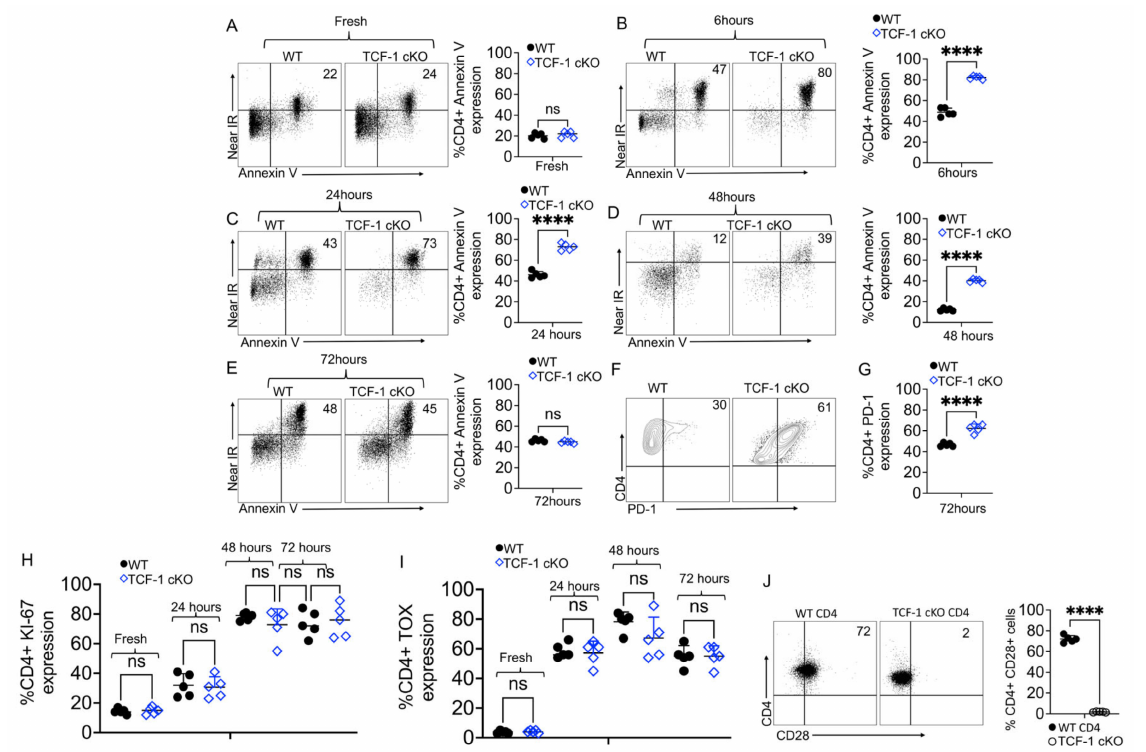
Figure 5. TCF-1 regulates CD4 T cell survival and persistence. ( A – E ) Splenocytes from either WT or TCF-1 cKO mice were isolated and either activated with anti-CD3/CD28 antibodies for 6, 24, 48, or 72 h in culture or left unstimulated, and cells were stained for Annexin V and Near IR to determine the dead, apoptotic and live cells. ( A ) Flow plots of CD4 T cells from either WT or TCF-1 cKO mice with quantitative and statistical analyses are shown at 0 h of the dead, apoptotic, and live cells in unstimulated ( B ) CD4 T cells from either WT or TCF-1 cKO mice were stimulated